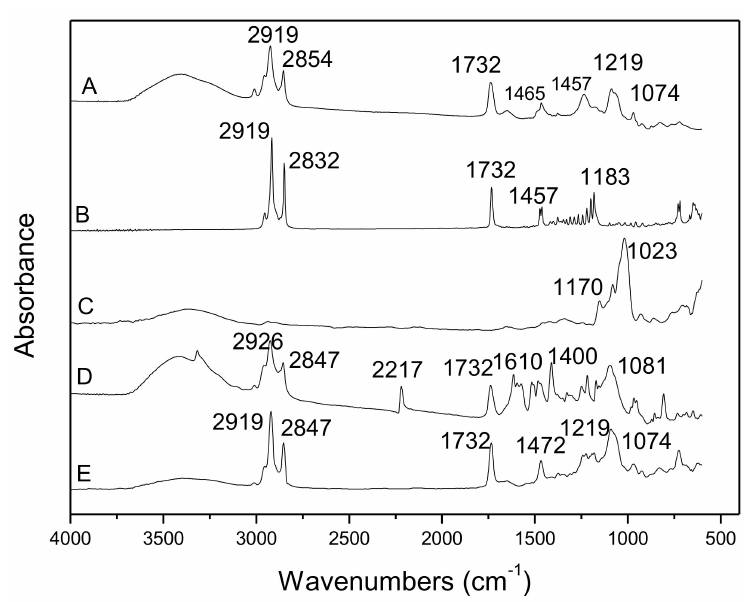
Figure 2. Fourier-Transform Infrared Spectroscopy (FTIR) spectra of ( A ) soybean lecithin; ( B ) cetyl palmitate; ( C ) PZQ; ( D ) PZQ- SLN; and ( E )